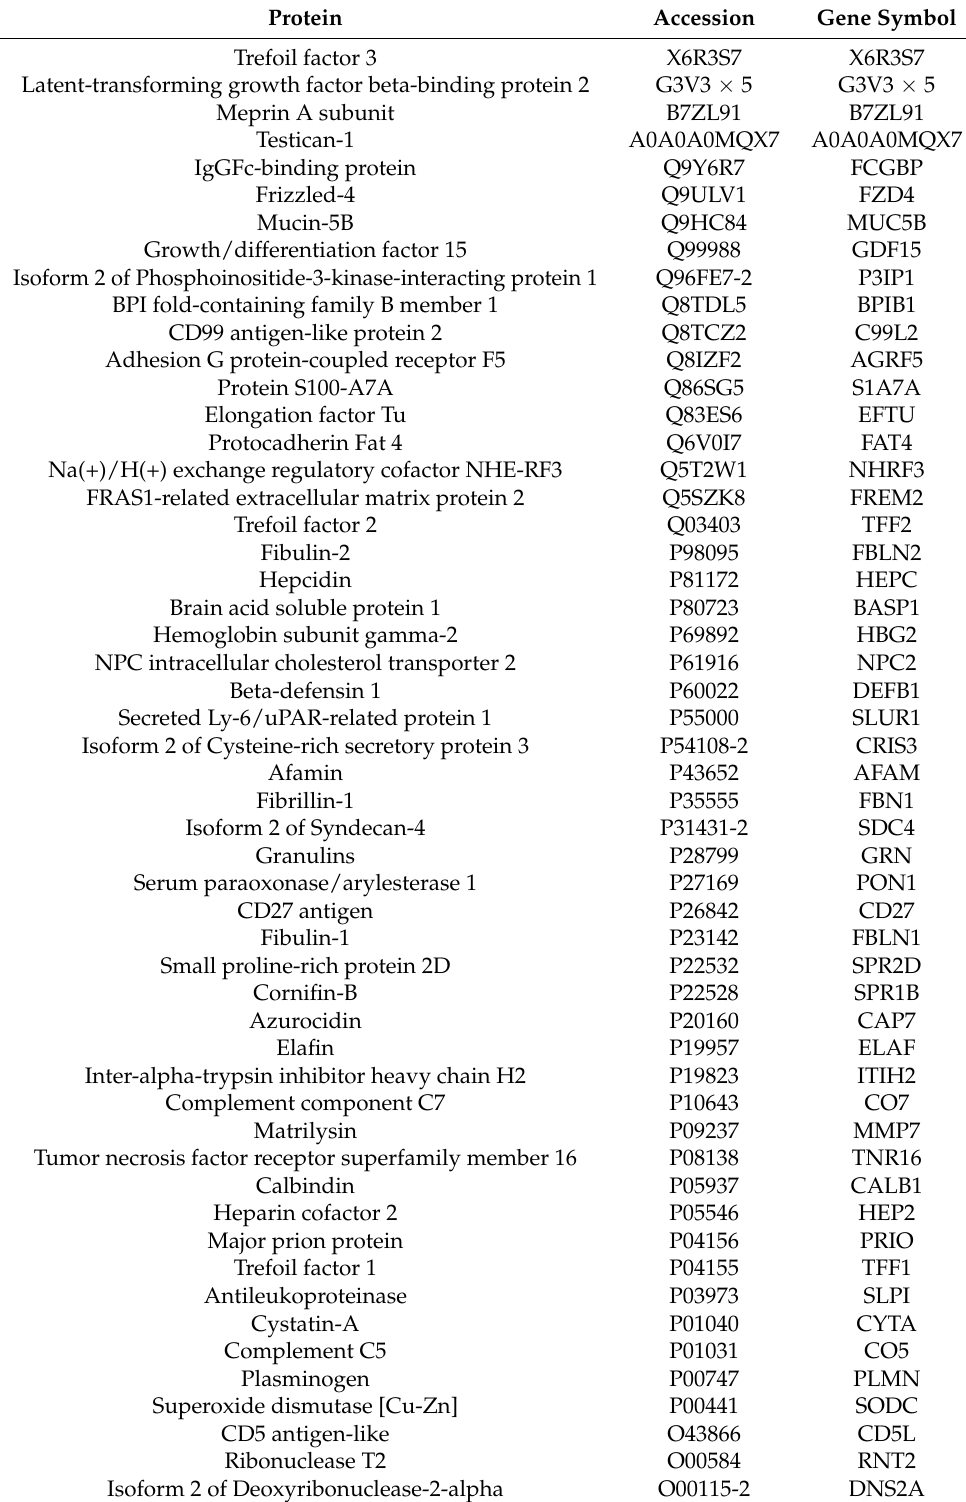
Table 3. Significant proteins detected in the control